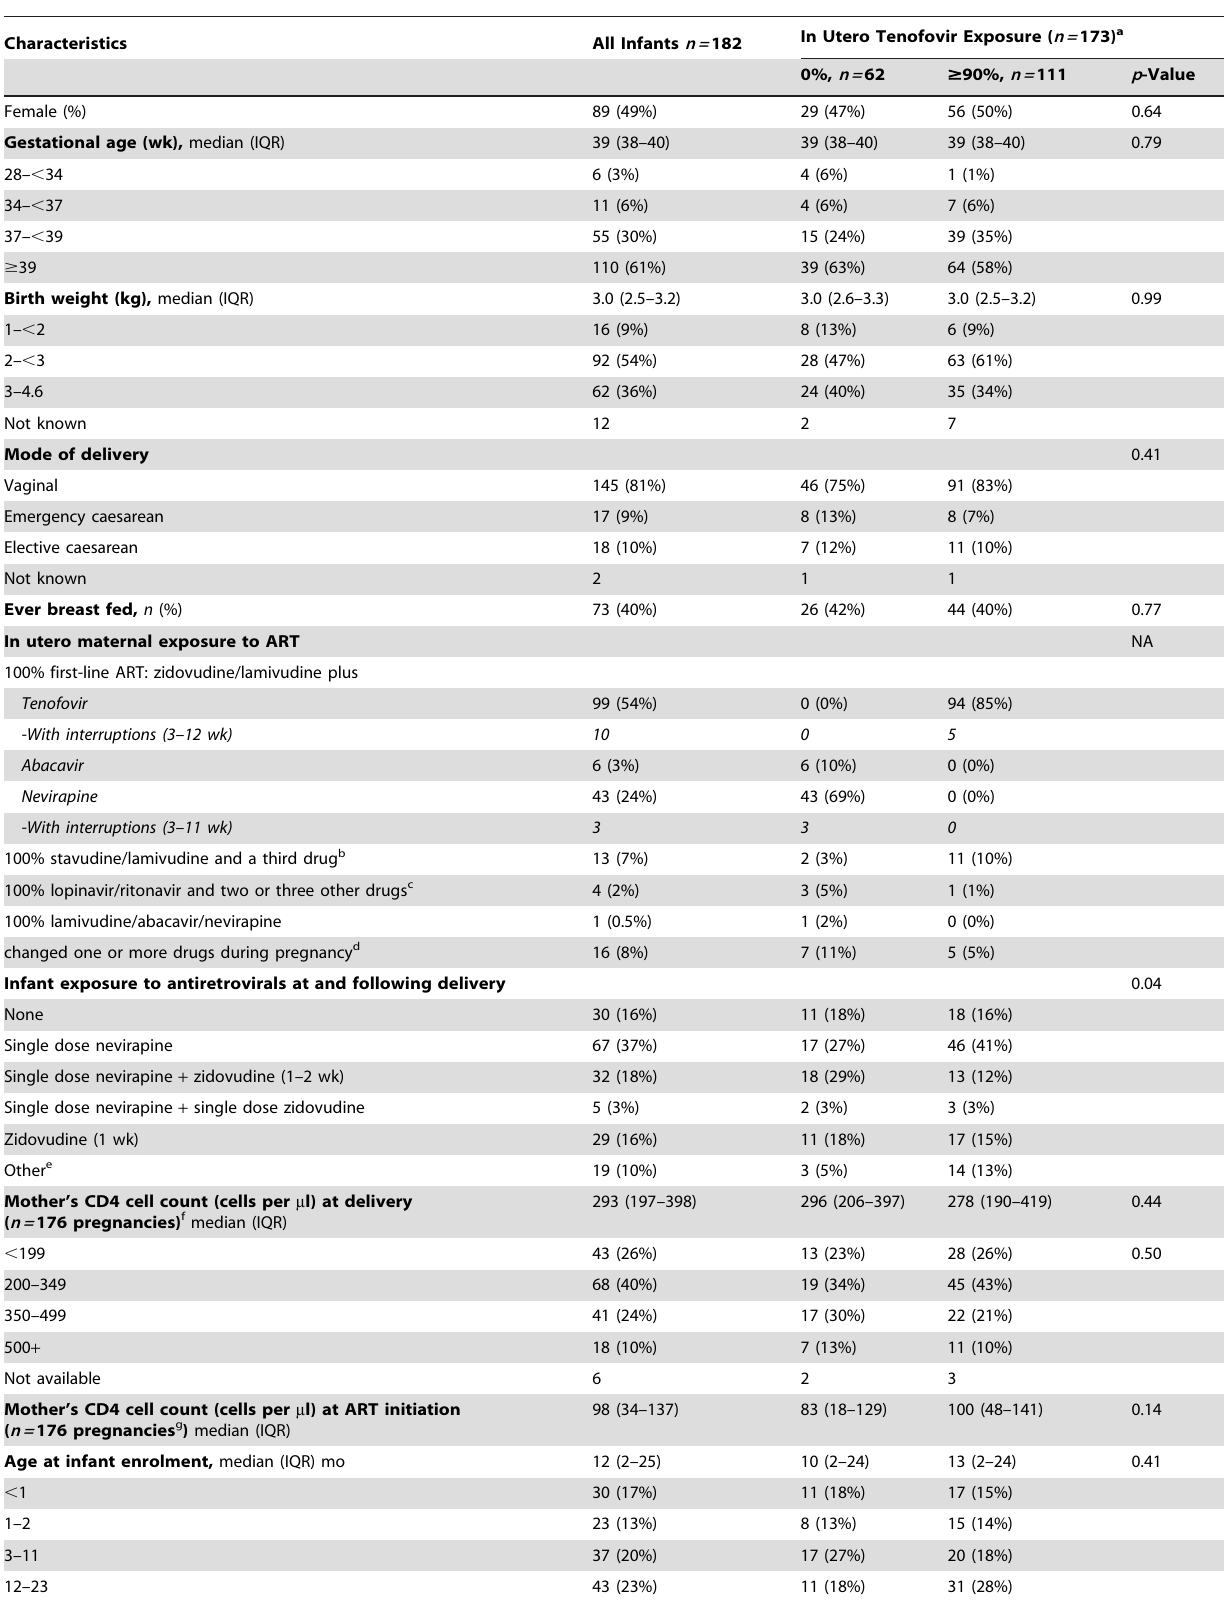
Table 1. Characteristics for all enrolled infants and according to whether they had received no or $ 90% in utero exposure to tenofovir.